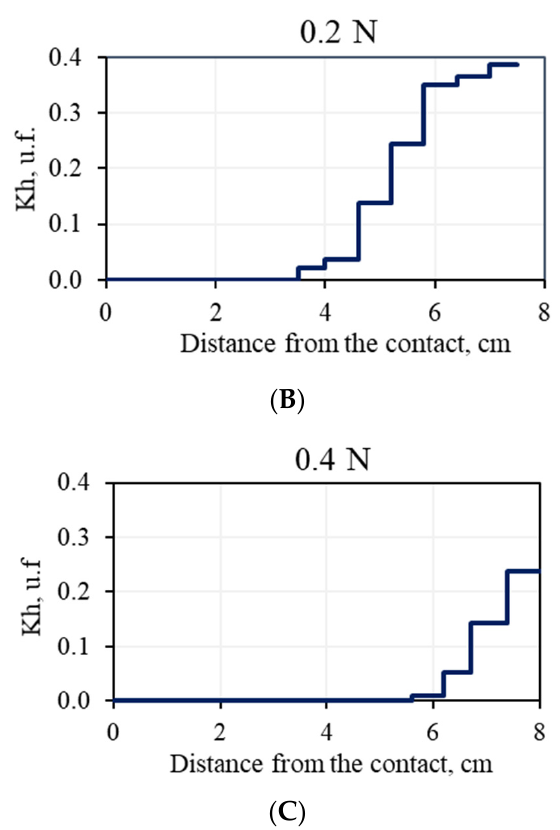
Figure 8. Variations of hydrate coefficient ( 𝐾 (cid:3035) ) along frozen hydrate-bearing sand samples ( 𝐾 (cid:3035)(cid:3036)(cid:3041) ~0.4, W = 12%) after four hours of interaction with 0.1 N ( A ), 0.2 N ( B ), and 0.4 N ( C ) NaCl solutions, at − 6.5 °C and 0.1 MPa.